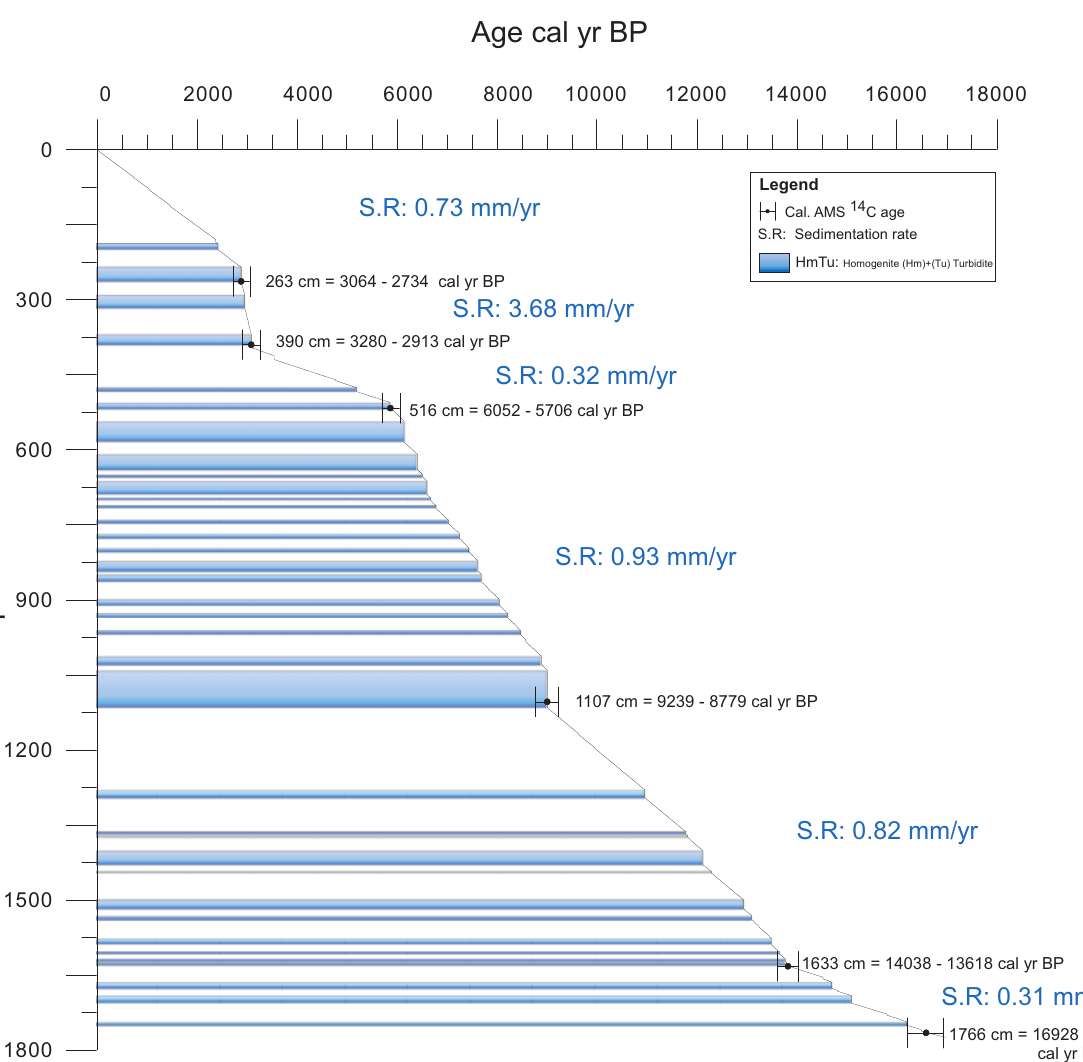
Figure 5. Proposed time distribution of HmTu events based on 14 C dating. Deduced sedimentation rate is applied to “hemipelagic” constant supply, without the supposed instantaneous